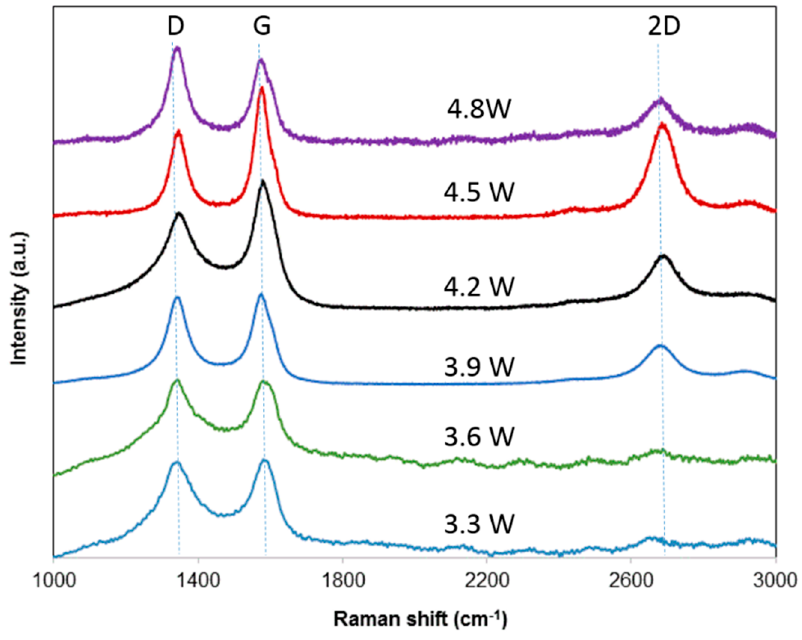
Figure 5. Raman spectrum of LIG obtained at various laser powers.